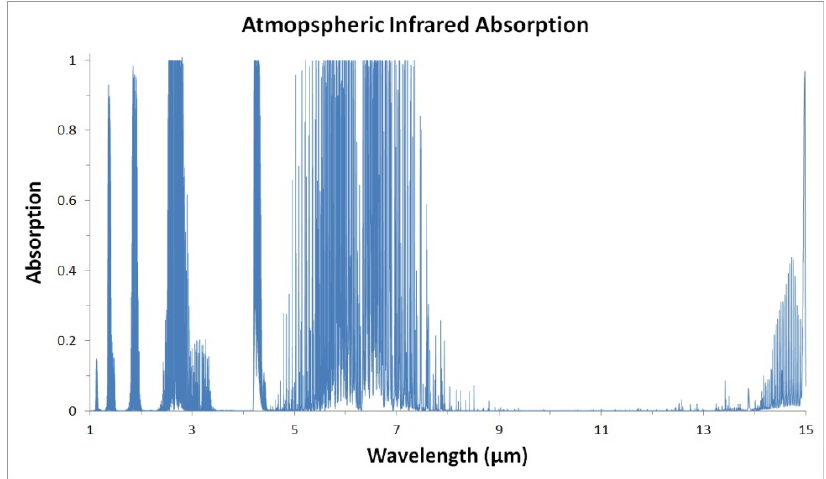
Figure 1. A plot of the atmosphere’s absorption spectrum [16]. Note that light emitted in the 2.5–3.5 and 5–7 µm ranges are rapidly absorbed by the